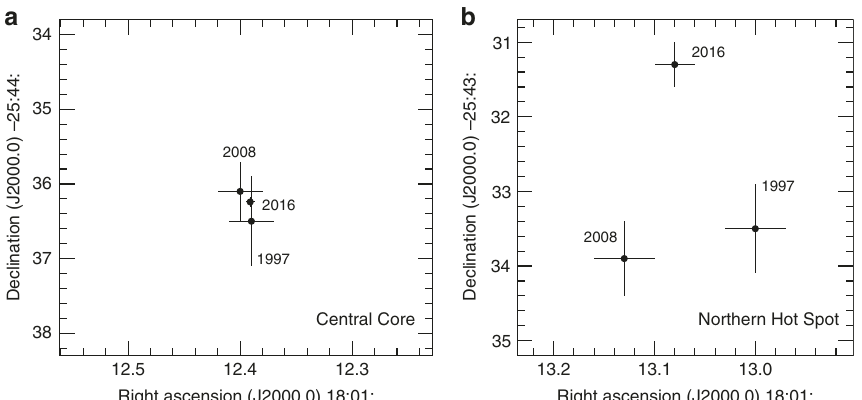
Fig. 2 Comparison of the central core and northern hot spot positions in GRS 1758-258. The equatorial coordinates of these microquasar features during selected epochs of VLA observations are displayed in the J2000.0 reference system. The a and b panels correspond to the central core and the northern hot spot, respectively. Although the central core remains fi xed within astrometric errors, the hot spot experiences clear shifts on the order of a few arcsec in time scales of years. Error bars correspond to one standard deviation, as reported by the JMFIT task of